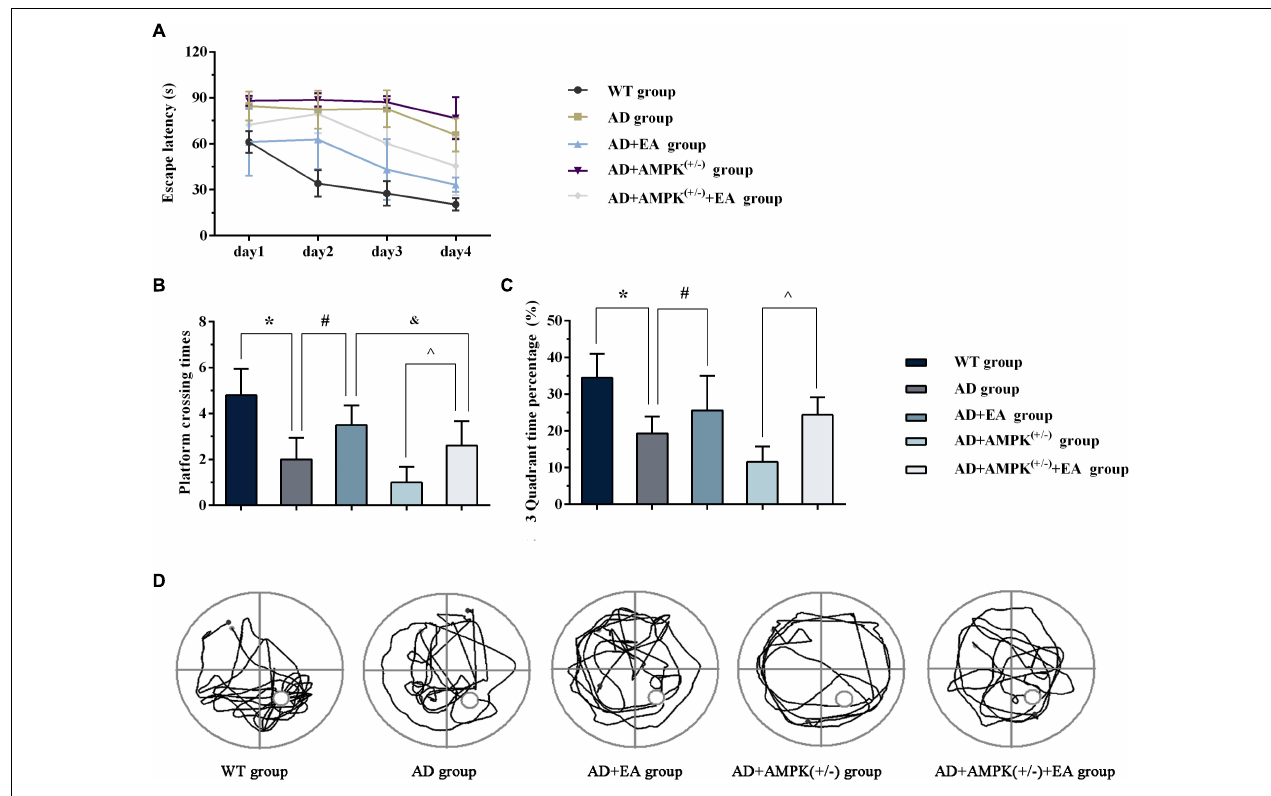
FIGURE 3 | Electroacupuncture intervention could improve the learning and memory abilities of APP/PS1 mice tested by Morris water maze. (A) The escape latency of five groups in Morris water maze after EA intervention; (B) The escape platform crossing times of five groups in Morris water maze after EA intervention; (C) The 3rd quadrant time percentage of five groups in Morris water maze after EA intervention; (D) Representative images of Morris water maze in different groups. * P < 0.05 vs. the WT group; # P < 0.05 vs. the AD group; ∧ P < 0.05 vs. the AD + AMP-activated protein kinase (AMPK) ( + / – ) group; & P < 0.05 vs. the AD + EA